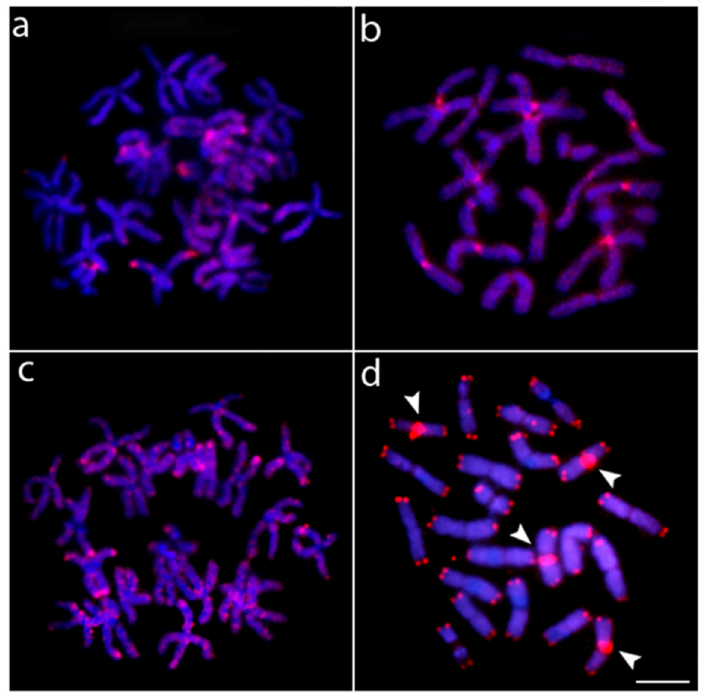
Figure 3. Metaphase chromosomes of N. anduzei after FISH hybridization with ( a ) (GA) 15 ; ( b ) (CGG) 10 ; ( c ) (CA) 15 microsatellite DNA probes, and ( d ) (TTAGGG)n sequences. Arrowheads indicate the interstitial telomeric sites (ITS) observed on pairs 4 and 6. Scale Bar = 10 μ m.